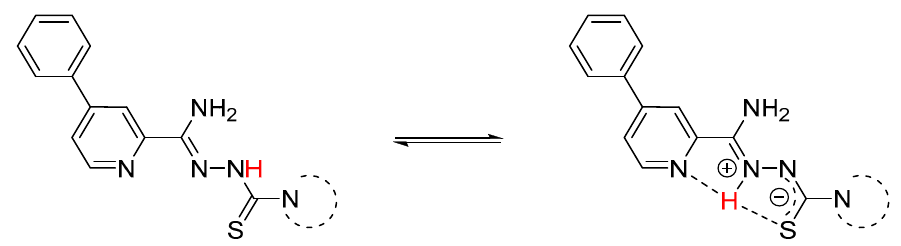
Figure 6. Tautomeric forms of compounds 1a – c . The labile hydrogen atom is marked in red.